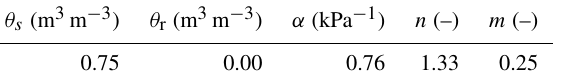
Table 5. Van Genuchten parameters (Eq. 1) fitted to the curve CD shown in Fig. 10b: saturated volumetric water content, θ s ; residual volumetric water content, θ r ; and parameters, α , n , and m .